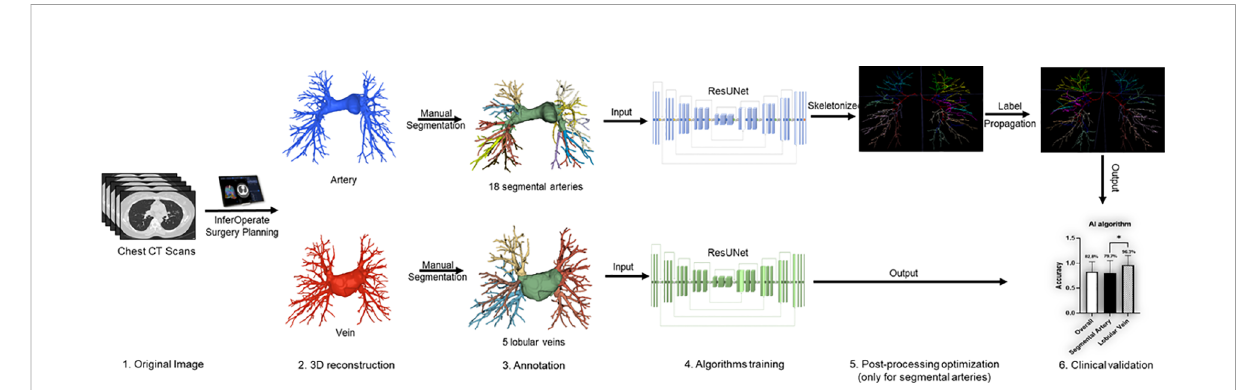
FIGURE 1 Work fl ow diagram of the deep learning (DL)-based pulmonary blood vessel segmentation